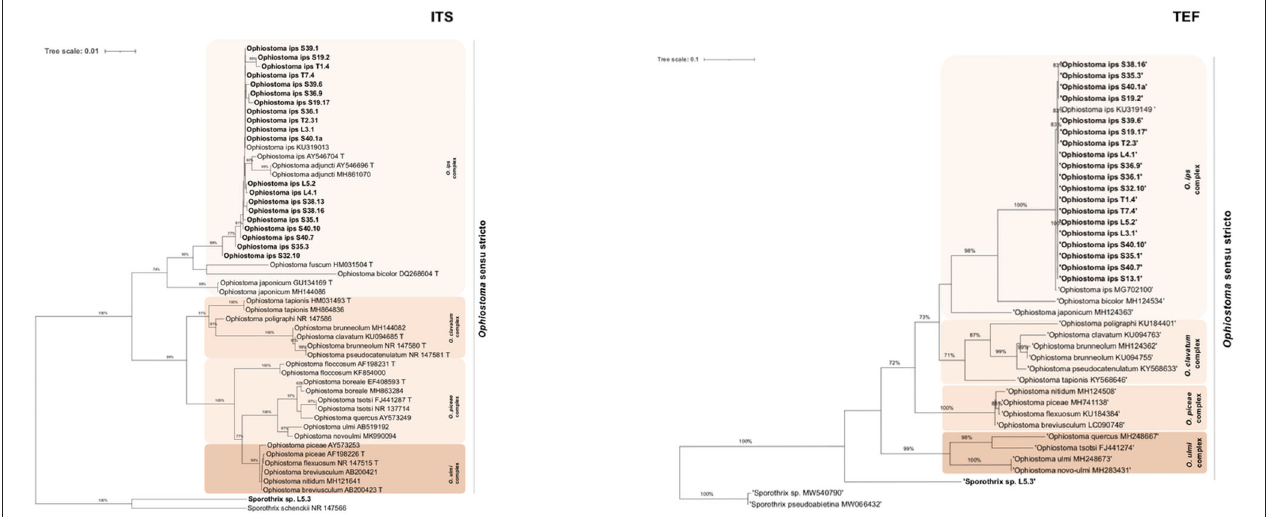
FIGURE 3 | Maximum likelihood trees of Ophiostoma sensu stricto generated by internal-transcribed spacer (ITS2) and elongation factor 1- α (TEF) DNA sequence data. Sequences generated from this study are presented in Bold ( Table 2 ). Bootstrap values ≥ 70% are presented above the respective branch. Branch length is a measure of the number of substitutions per site (scale bar). T = ex-type